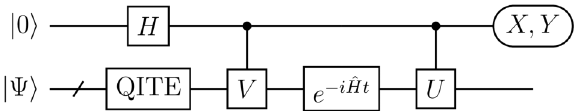
FIG. 1. Quantum circuit to calculate the finite-temperature dynamical correlation function (cid:9) U ( t ) V (cid:7) β . The ancilla qubit is ini- tialized in | 0 (cid:7) and the system qubit are initialized in | (cid:6) (cid:7) . Here / denotes a bundle of qubits. Measuring X ( Y ) on the ancilla yields the real (imaginary) part of (cid:9) U ( t ) V (cid:7) on the QITE-evolved initial state. Performing a thermal average over all initial states yields (cid:9) U ( t ) V (cid:7) β